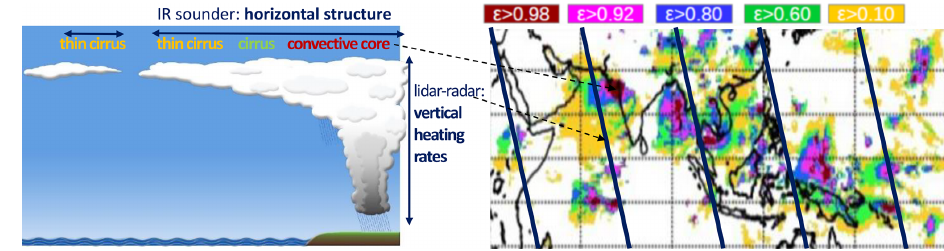
Figure 1. Illustration of the three-dimensional cloud system concept, using space-borne IR Sounder data (AIRS), providing the horizontal component, and lidar–radar data (CALIPSO–CloudSat), providing the vertical component, both part of NASA’s A-Train satellite constellation (left): based on two independent variables retrieved by AIRS, UT cloud systems are reconstructed from adjacent elements of similar cloud height ( p cld ); the horizontal emissivity structure allows the properties of convective cores ( ε cld > 0 . 98) and cirrus anvils (right) to be directly linked. Clear-sky and low-level cloud fields are also identified (Fig. 4a of Protopapadaki et al., 2017). A horizontally complete picture of the vertical radiative heating rates will be obtained by laterally expanding them, as they are only available along narrow lidar–radar tracks (dark blue). Therefore we have developed optimized “non-linear regression models”, using deep neural network learning techniques, described in Sect. 2.4 and evaluated in Sect. 3, to relate the most suitable cloud and atmospheric properties from IR sounder and meteorological reanalyses to these heating